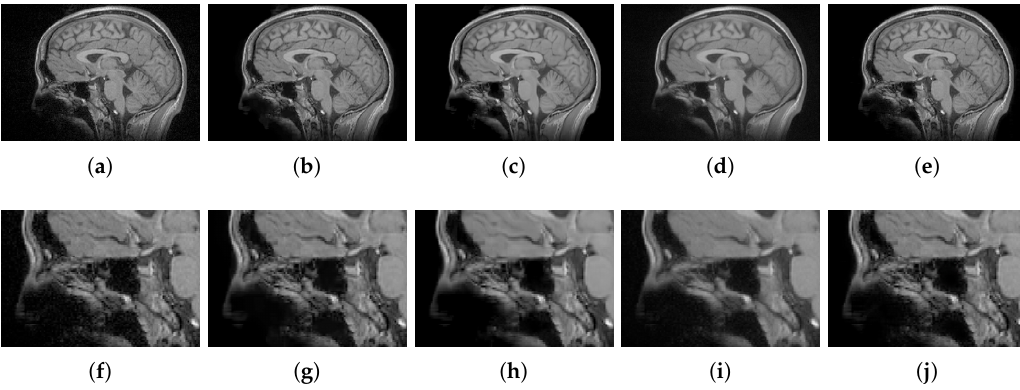
Figure 18. Quality comparisons on a real T1w MR image. ( a ) Original MR image, ( b – e ) denoising results of the PRINLM, the BM4D, DnCNN, and the NLSD. ( f – j ) the corresponding zoom-in of figures ( a – e